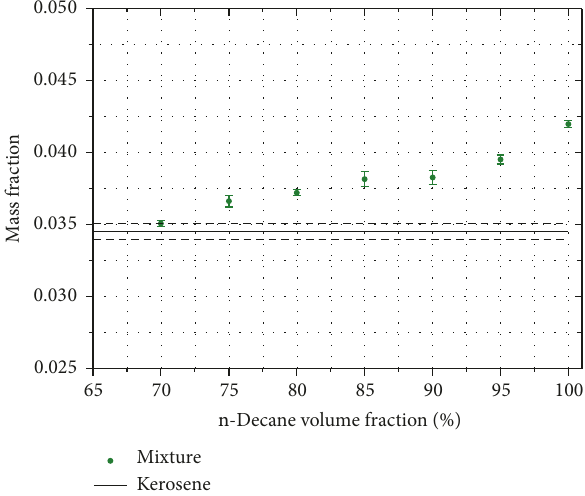
Figure 6: Comparison of mass fraction of O2 for the surrogate and the kerosene burning.